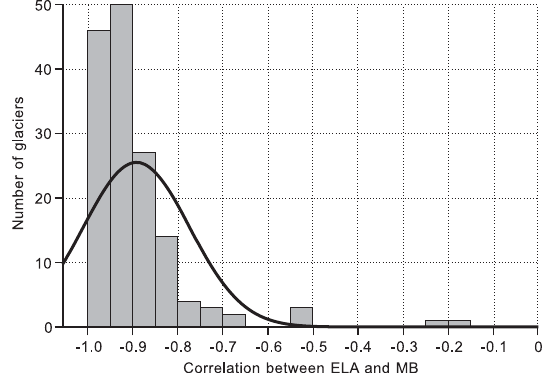
Figure 4. Histogram showing number of glaciers vs. correlation co- efficients between equilibrium line altitude (ELA) and mean spe- cific balance. The bold line denotes a Gaussian curve with the same mean and standard deviation as the plotted data.